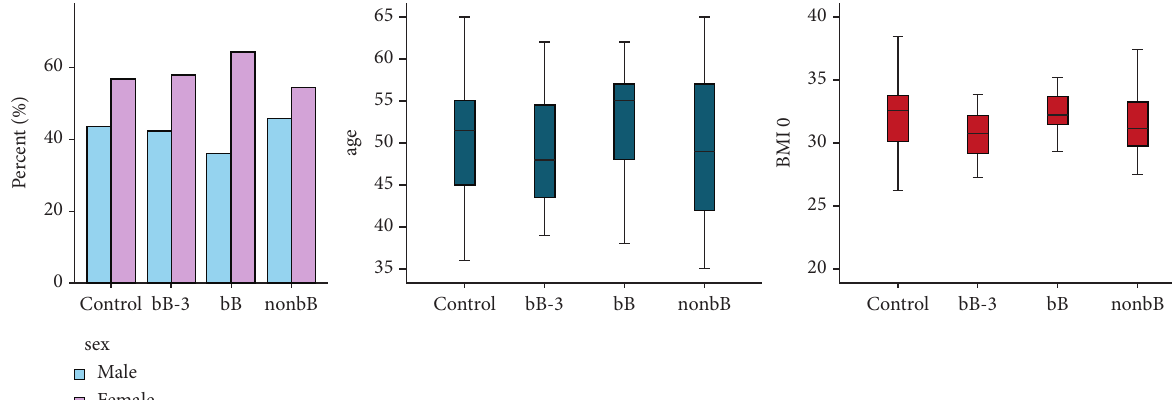
Figure 1: Sex distribution, age distribution, and baseline BMI (BMI 0) in the study population: the enrolled patients, aged 50.30 ± 1.13 years, had a mean BMI of 31.79 ± 0.65kg/m2; 90 subjects (F : M � 1.36) were taking antihypertensive drugs; 30 subjects (M: F � 1.31), not receiving any antihypertensive therapy in the past 12 months, were enrolled as controls.